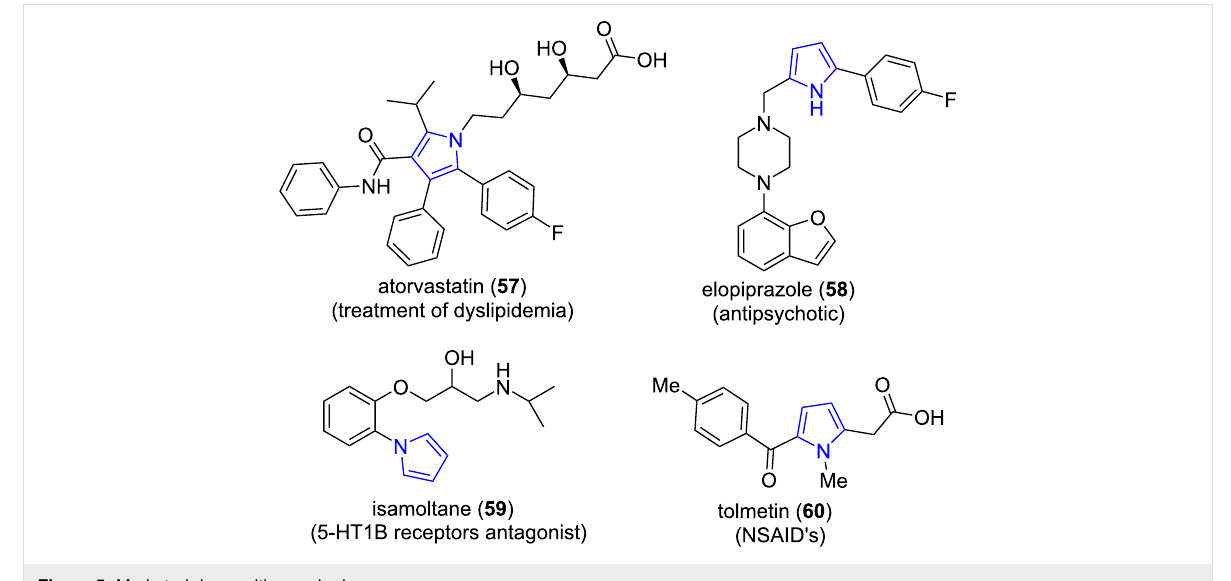
Figure 5: Marketed drugs with pyrrole ring.